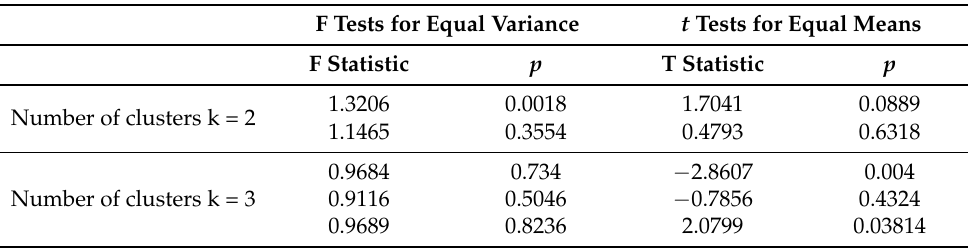
Table A1. Test statistics and associated p values for comparing the cluster means ( t -tests) and cluster standard deviations (F tests) between the resampled and original Australian soybean data. F Tests for Equal